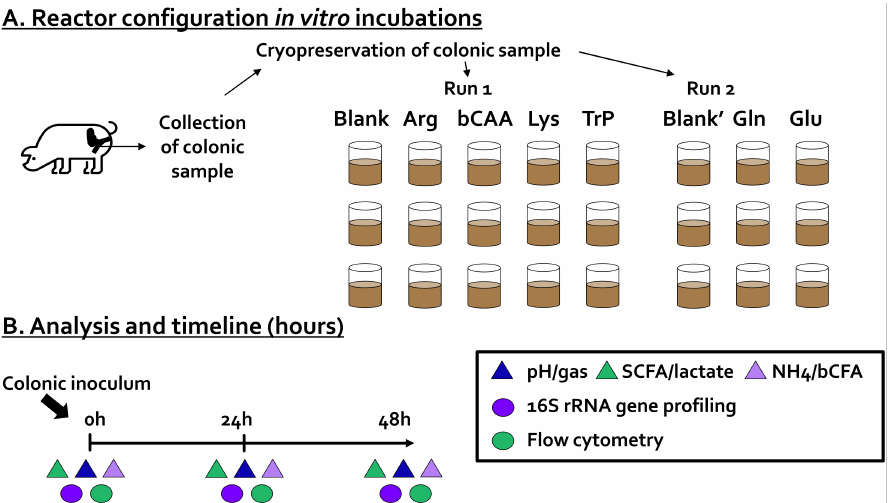
Figure 1. ( A ) Reactor configuration and ( B ) timeline of the in vitro experiment during which the impact of amino acids on the activity and composition of a porcine colonic microbiota was inves- tigated. Arg = arginine, bCAA = branched-chain amino acids (leucine, valine and isoleucine in a 1:1:1 ratio), bCFA = branched-chain fatty acids, Gln = glutamine, Glu = glutamate, Lys = lysine, NH 4 = ammonium, SCFA = short-chain fatty acids, Trp =